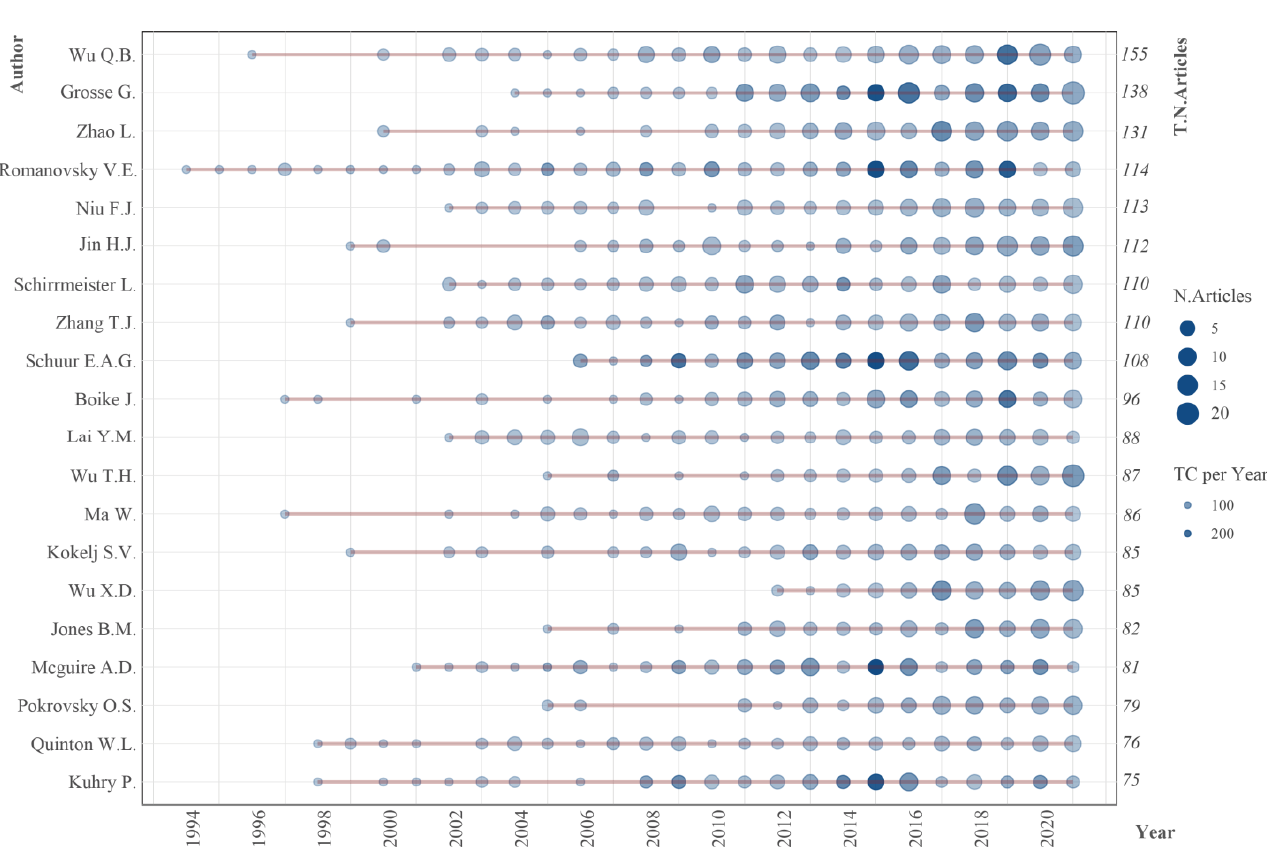
Figure 9. Top 20 authors by production over time, ranked in terms of the total number of publications. The circle size presents the annual total number of articles; the color from light blue to blue indicates increasing total citations per year, and the italic value in the right y-axis is the total number of publications for every author. N.Articles and TC per Year mean the number of published papers and total citations for each author within one year, respectively.